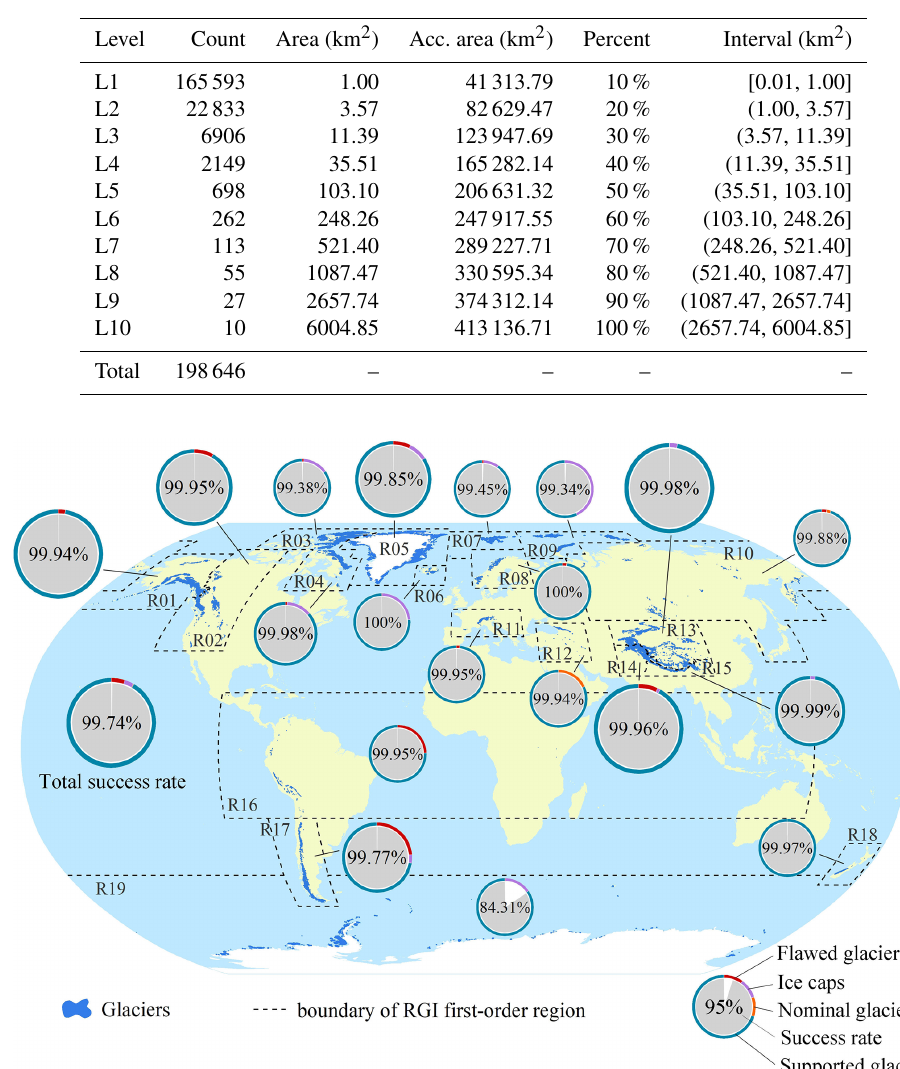
Table 3. Global glaciers stratified by area.